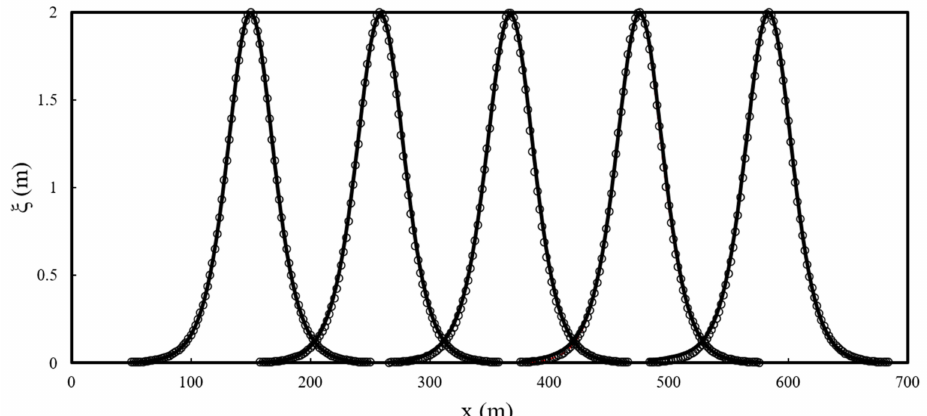
Figure 3. Comparison of numerical results and analytical solutions of free surface elevations at t = 0, 10, 20, 30 and 40 s. Analytical solutions (circles), numerical results (solid lines).